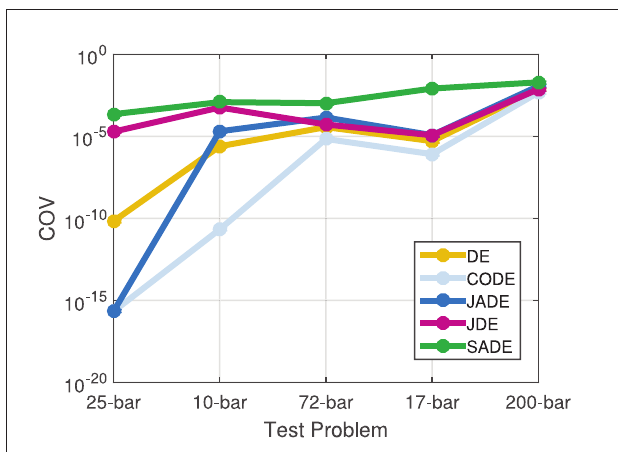
FIGURE 6 | Coefficient of variation (COV) values for each problem and